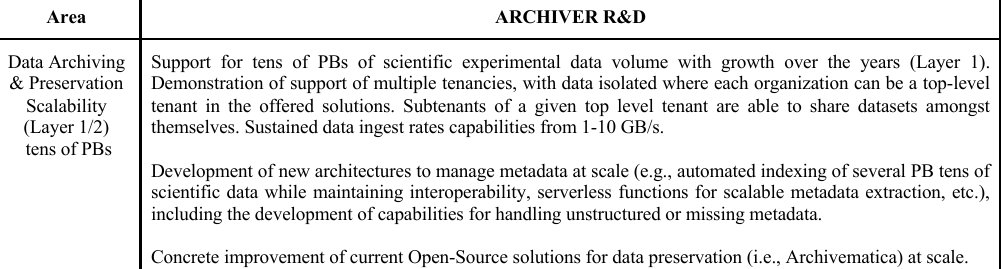
Table 1. Main areas of